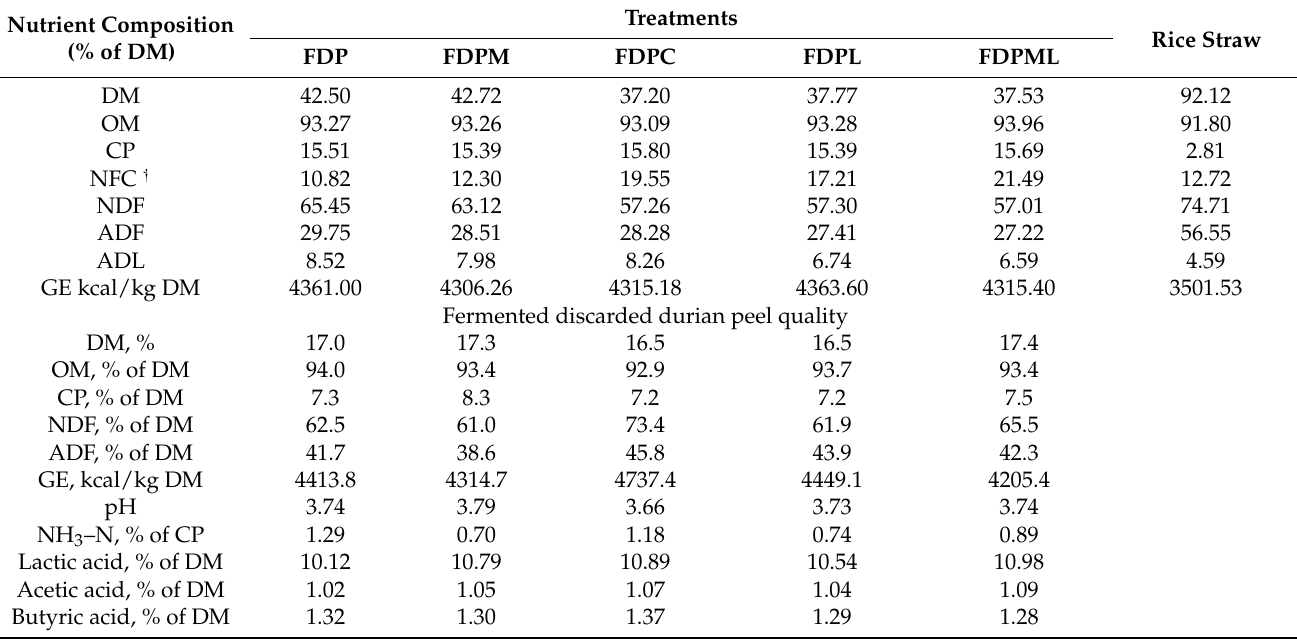
Table 1. Nutrient composition of TMR diets, rice straw, and fermented discarded durian peel quality treated with or without additives.